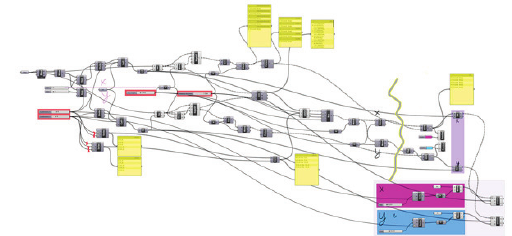
Figure 4. Full Grasshopper definition from selection of the surface to the choice of material thickness and structural dimensions, as well the automated drawing of the contour outlines of all the pieces for laser